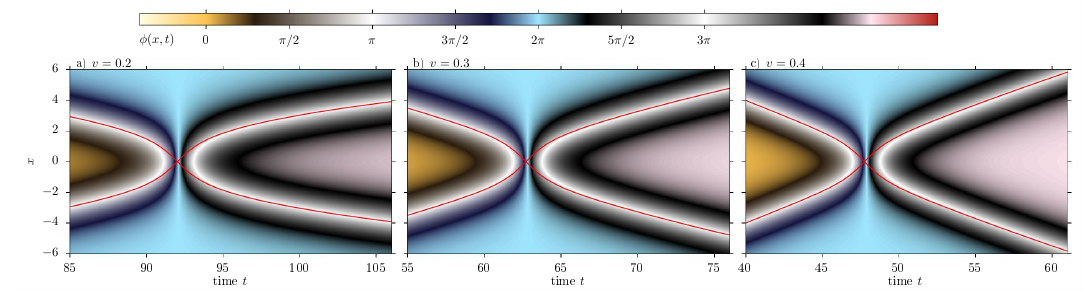
Figure 10 . Close-up views of the initial collision for the top row of plots of figure 8, comparing the full field theory results with the predictions of the effective model, which are shown with continuous red